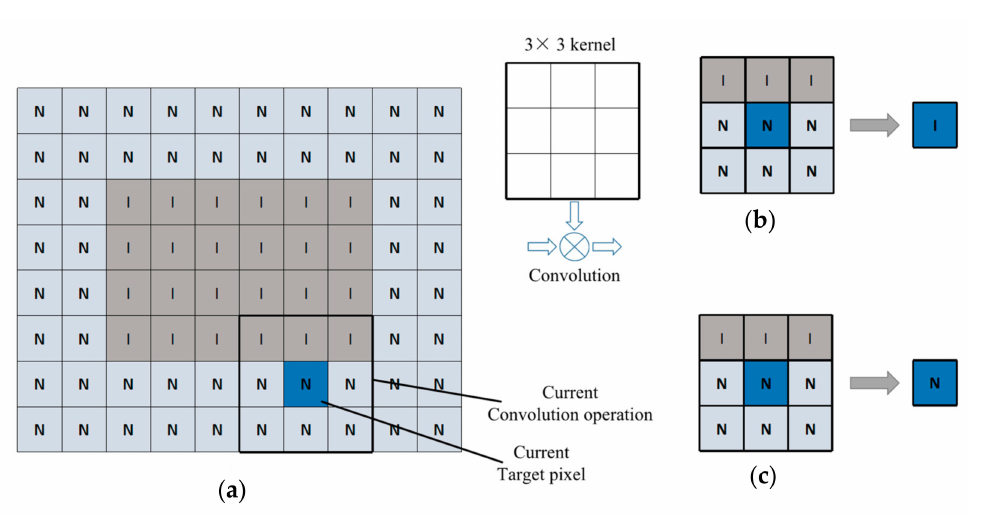
Figure 6. ( a ) The example of the ROI and convolution operations. ( b ) The ROI output of TH0. ( c ) The output ROI of